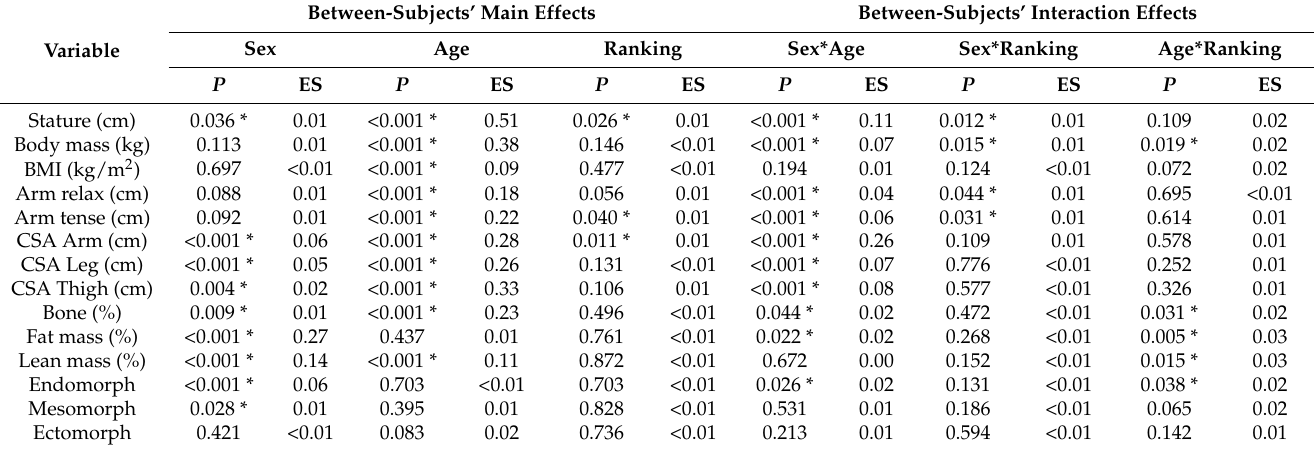
Table 2. Effects of sex, age, ranking, and their interactions on morphological characteristics of table tennis players for sex and age (n = 495).